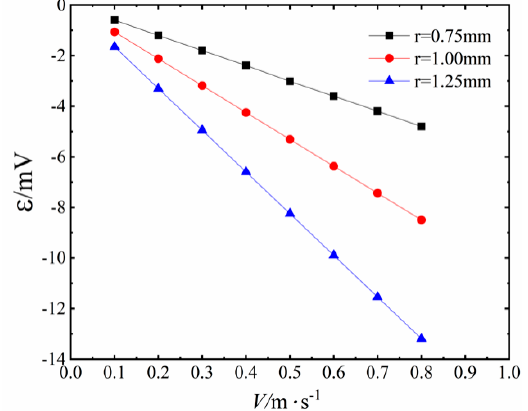
Figure 9. Variation of induced electromotive force with the fluid velocity of working fluid under different inner radii of the PHP.